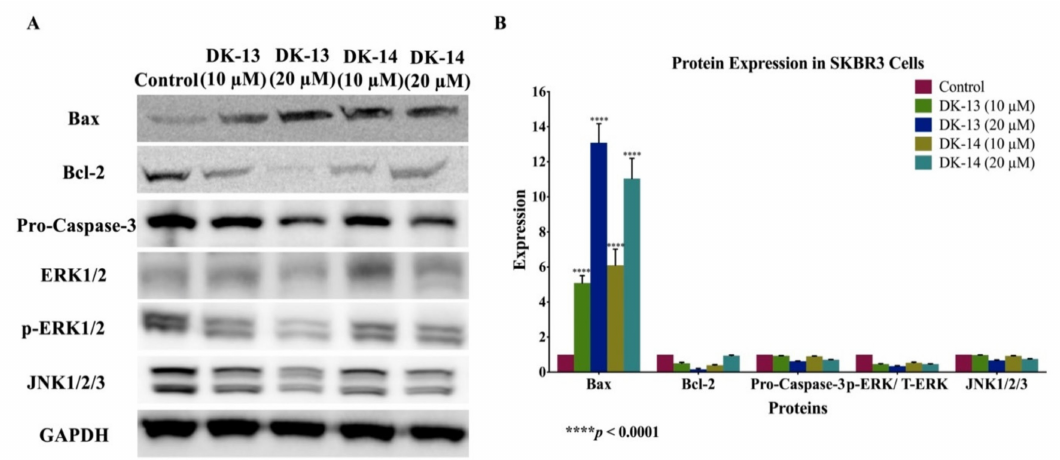
Figure 6. ( A , B ). Protein expression and molecular mechanisms of chalcone compounds’ (DK-13 and -14) inhibitory actions in SKBR3 cell line. Chalcone compounds induce the expression of pro-apoptotic markers Bax and Caspase-3 in comparison with their control, while anti-apoptotic marker Bcl-2 is inhibited. Furthermore, these compounds both inhibit the expression of JNK1/2/3 and enhance ERK1/2. GAPDH was used as a control in this assay. Cells were treated with 10 and 20 µ M of DK-13 and -14 compounds for 48 h, as explained in the Materials and Methods section. ( A ) Blot image and ( B ) quantification of